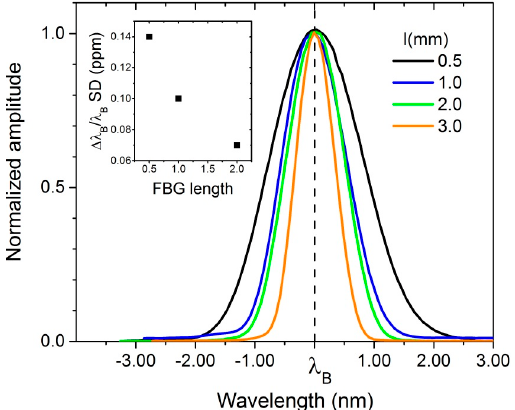
Figure 13. FBG reflections at λ B from sensors of different lengths (0.5, 1.0, 2.0 and 3.0 mm) manufactured by Technica SA, relative to λ B = 1550 nm. Inset. The standard deviation (SD) for the peak position obtained using a center-of-mass algorithm was obtained over a data acquisition period of one minute, and from it, ∆ λ B / λ B is computed. As expected, narrower reflections lead to an increased sensitivity when other parameters, such as intensity etc., are kept constant. Narrower peaks, however, require longer samples in the experiment.